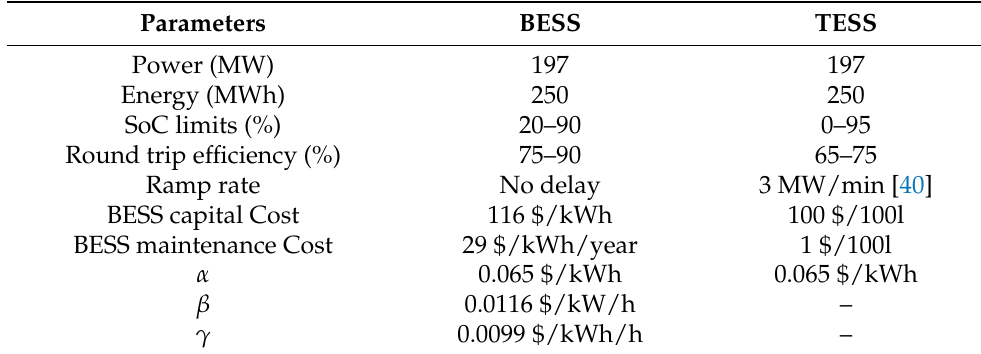
Table 4. Parameters of storage